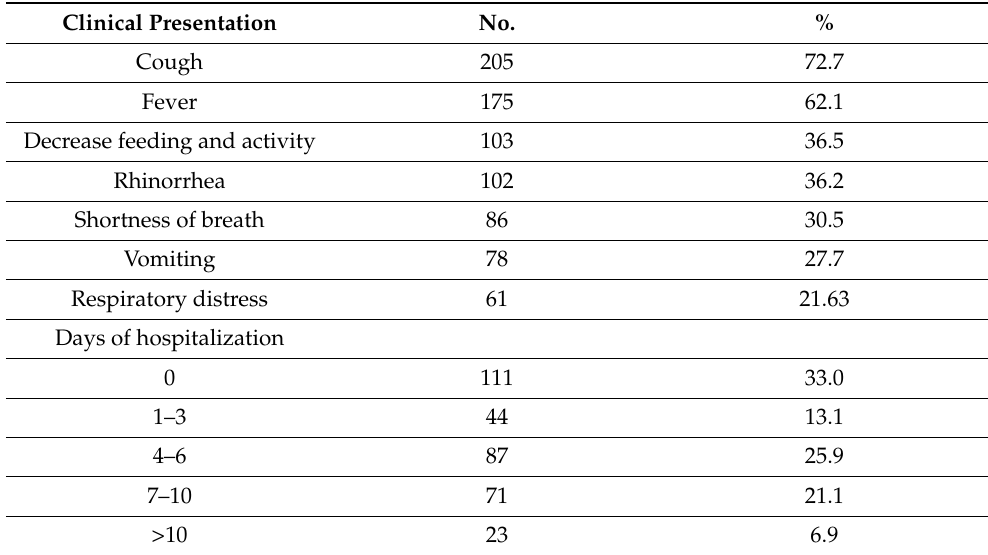
Table 3. Clinical manifestation and days of hospitalization associated with RSV infection.